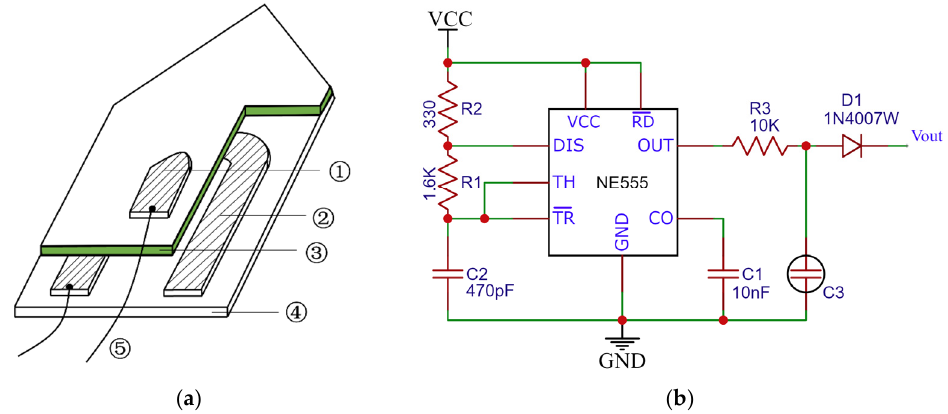
Figure 2. Structure and principle of RC resonant capacitor probe. ( a ) Structural diagram; ( b ) circuit diagram. ① Upper plate; ② lower plate; ③ high humidity-sensitive polymer membrane; ④ sub- strate; ⑤ leads.